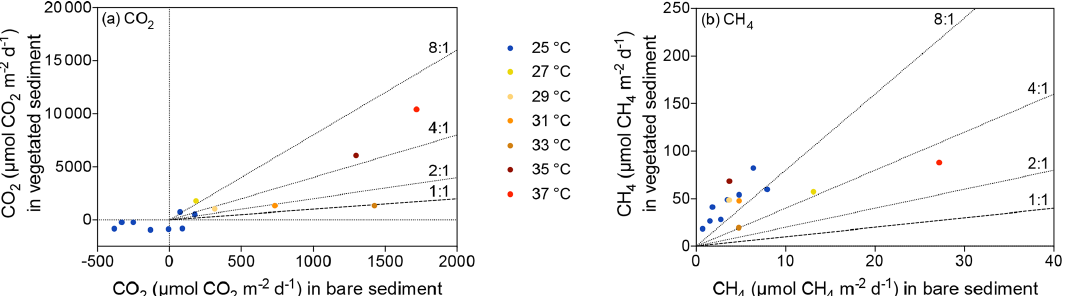
Figure 3. Relationship between vegetated and bare sediments for (a) CO 2 and (b) CH 4 fluxes. Symbols indicate different temperatures ranging from 25 to 37 ◦ C; the dashed line indicates 1:1; and dotted lines show 2:1, 4:1 and